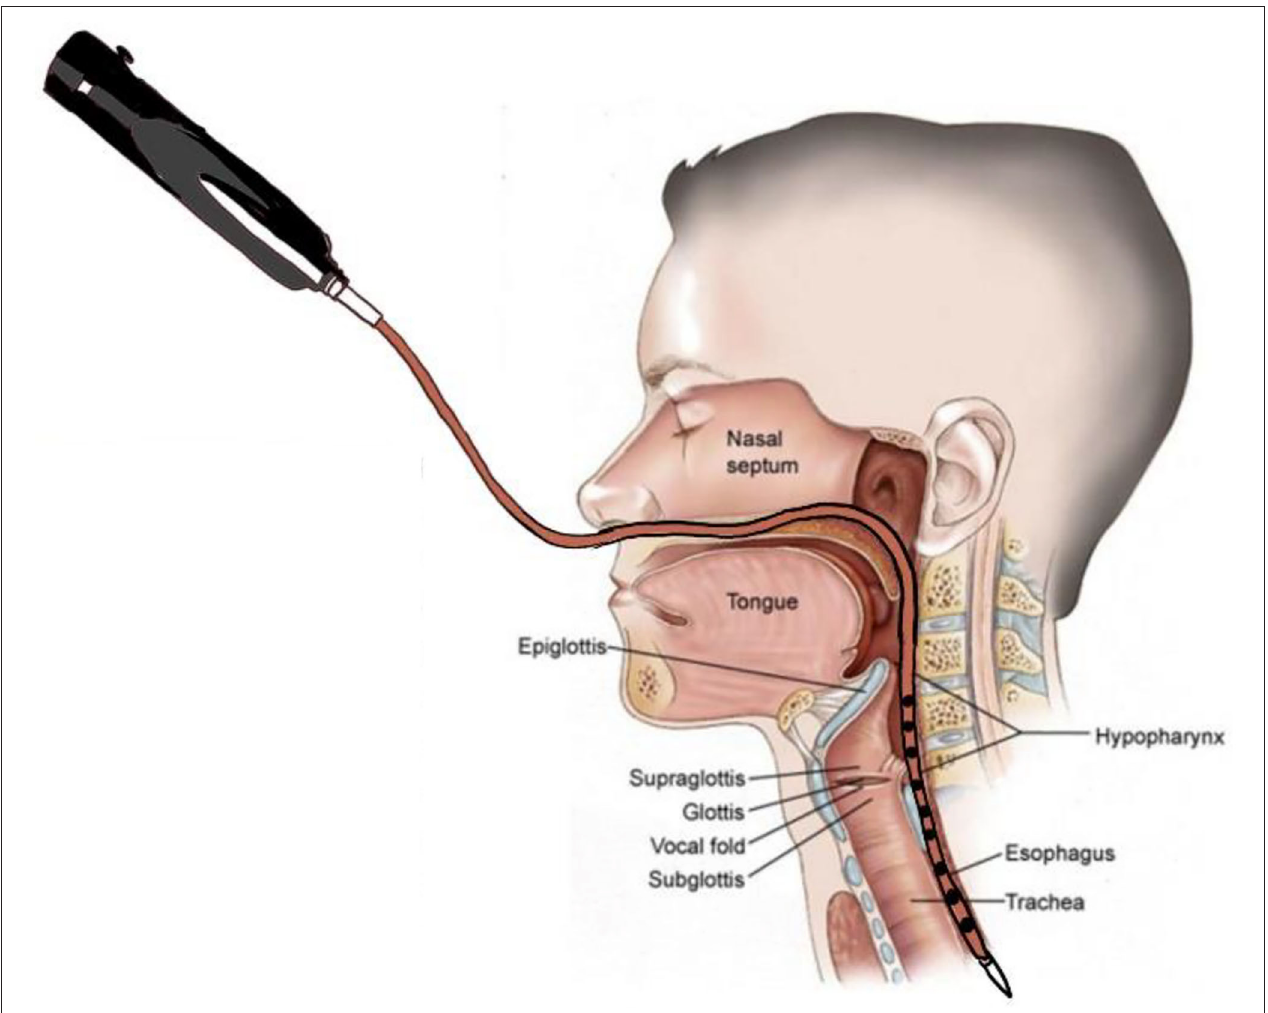
FIGURE 2 | Swallow function recorded by High-Resolution Impedance Manometry (HRIM). The HRIM tube is shown in a patient’s pharyngeal